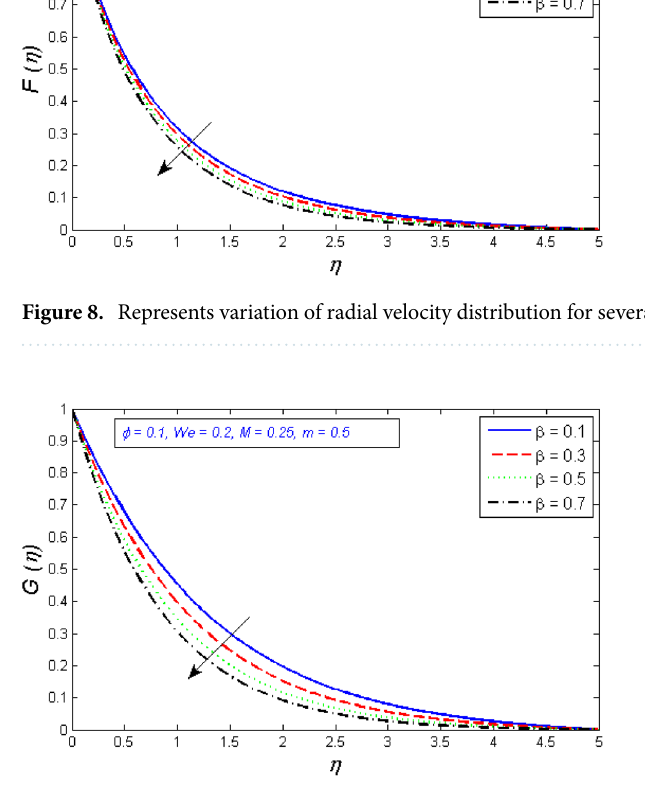
Figure 9. Represents variation of tangential velocity distribution for several number of porosity parameter β .